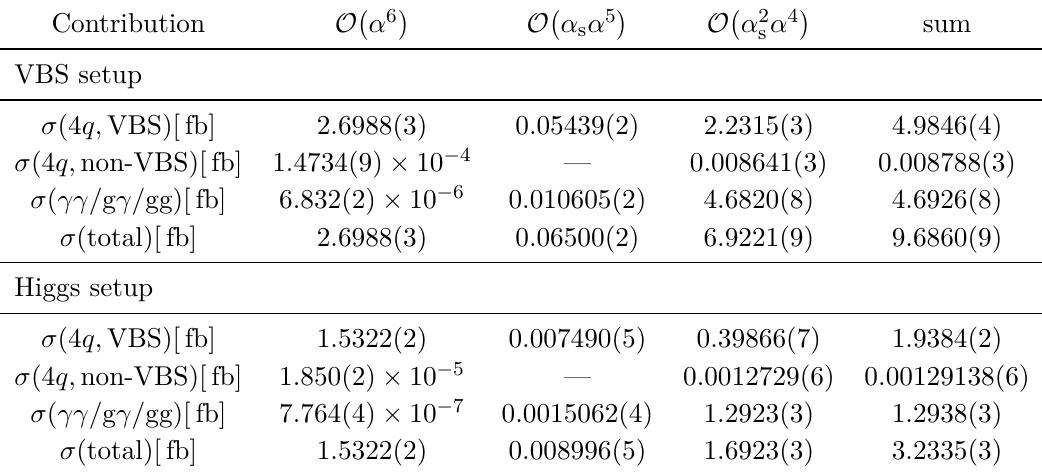
Division of LO cross sections into contributions of partonic channels with specific subprocesses. Note that no non-VBS processes containing two quarks in both the initial and final (cid:0) (cid:1) state contribute at order α s α 5 O